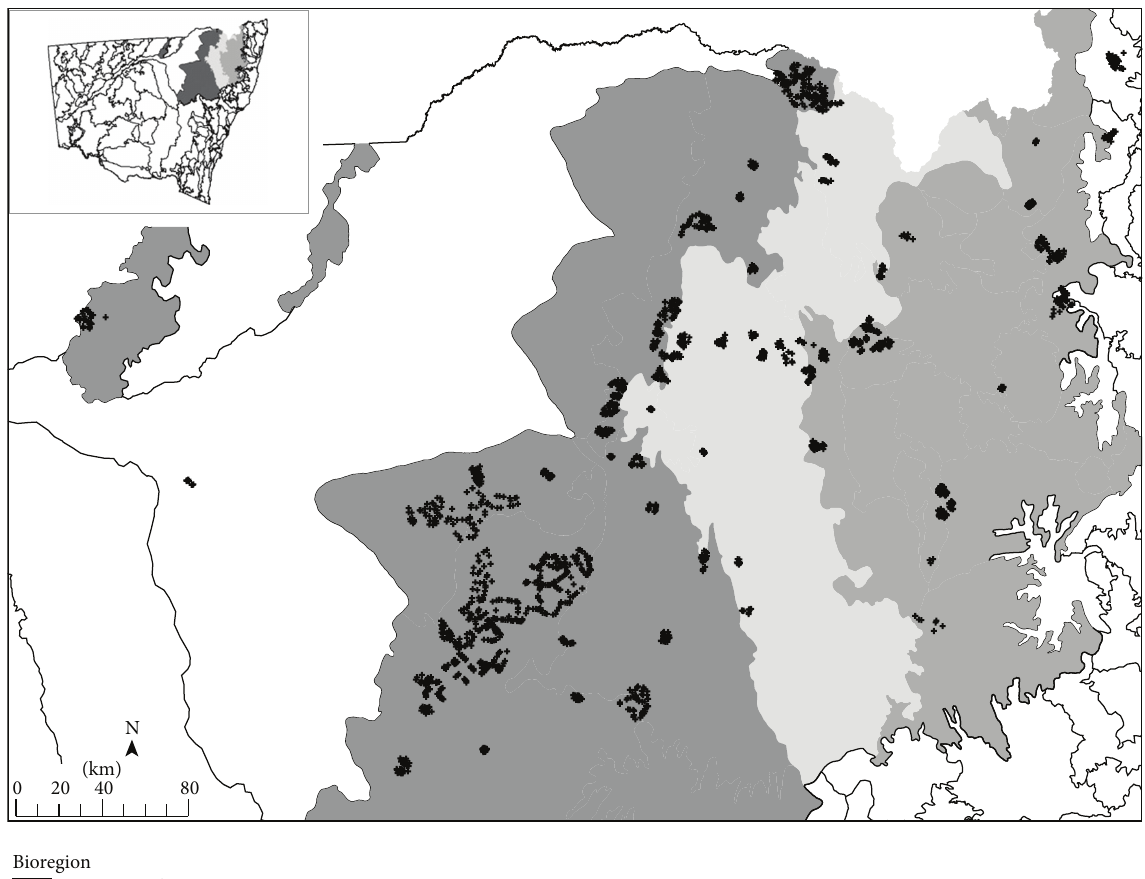
Figure 1: Location of 2,341 structural survey sites within northeastern New South